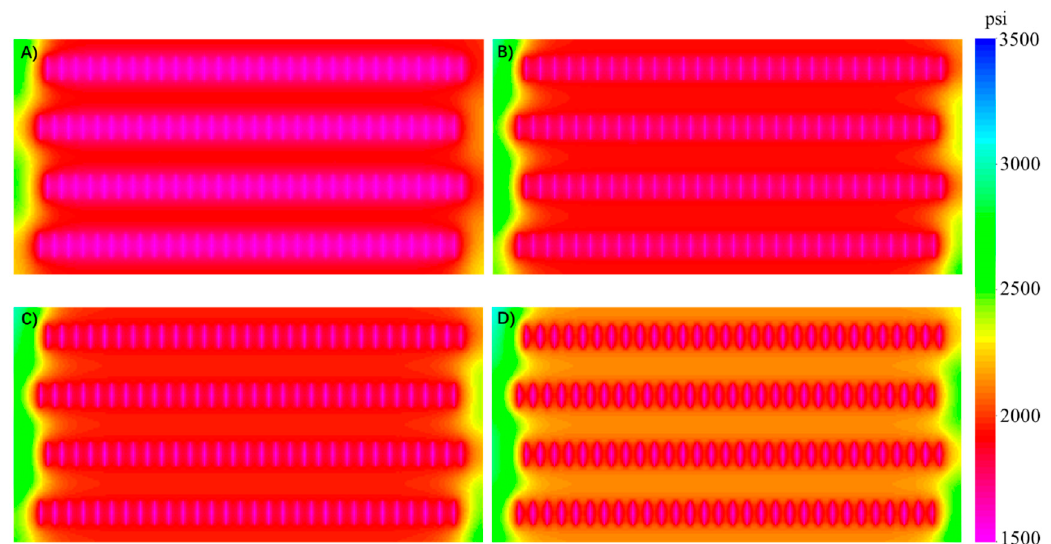
Figure 15. Difference of pressure distribution in different scenarios. ( a ) Case A; ( b ) Case B; ( c ) Case D; ( D ) Case ( d ) Case C.